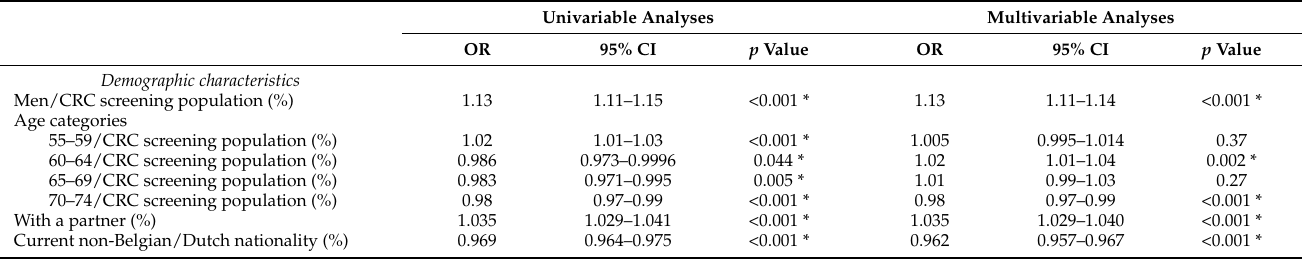
Figure 3. Associations between municipal characteristics with organised and non-organised screening coverages, presented with adjusted odds ratios and 95% confidence intervals. Table 3. Univariable and multivariable associations between municipal characteristics and organised FOBT screening